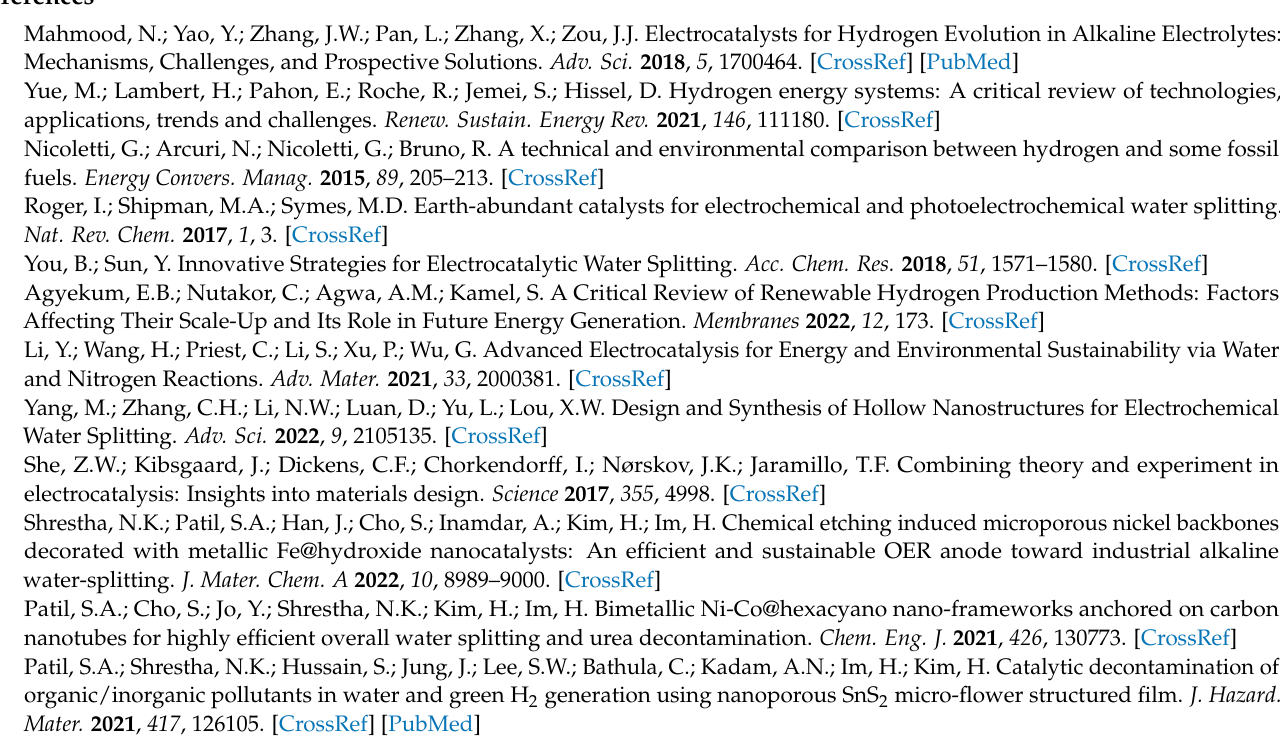
MOF film, Figure S2: ESCA specific UOR LSV polarization curves. Figure S3: Tafel slopes for UOR ex- tractedfromthecorrespondinganodicLSVpolarizationcurvesof“Figure5a,b”. Figure S4: Electrochemical impedance spectroscopy. Figure S5: CV plots of the Fe-MOF/NF and Cu/Fe-MOF/NF electrodes and double-layer capacitance (C dl ) values estimated from the corresponding CV plots. Figure S6: UOR current density vs. Vcell profile for the overall urea-splitting electrolyzers. Table S1: Comparison of UOR performance for the Cu/Fe-MOF/NF with respect to reported high-performance UOR electrocatalysts. References [64–75] were cited in Supplementary